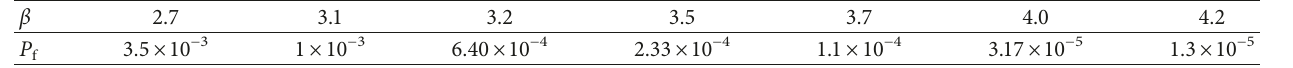
Table 11: Relationship between β and P